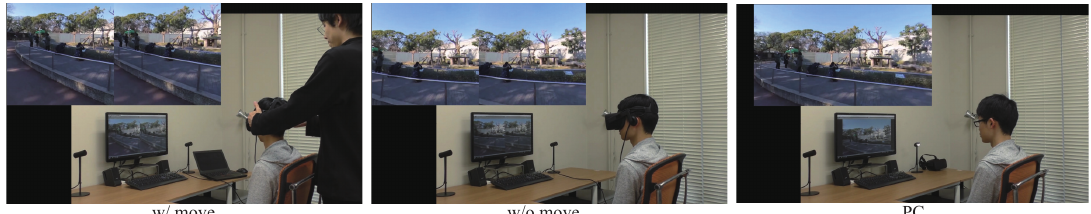
Figure 9. Appearance of the participant watching a video taken at the